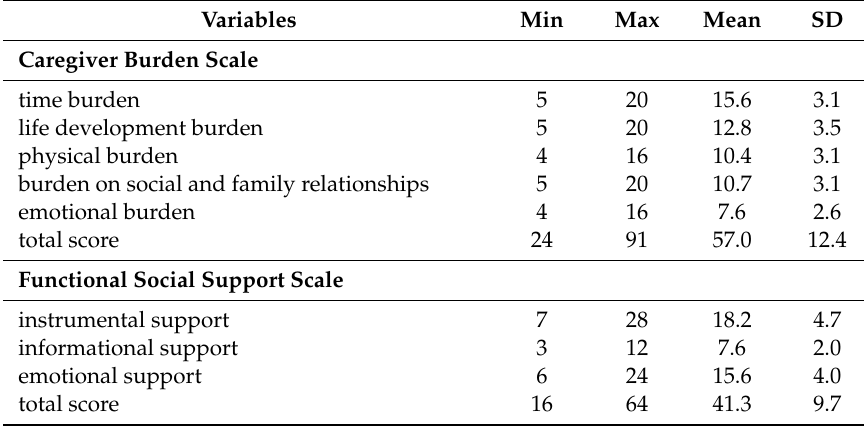
Table 2. Scores of Burden on caregivers and social support